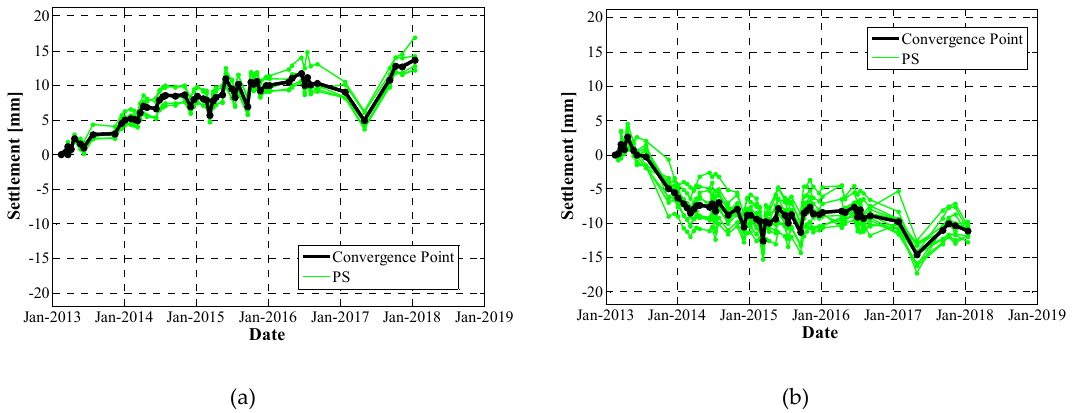
Figure 5. Settlement evolutions of the PS and their convergence points in the ( a ) north and ( b ) south parts of the building, respectively.